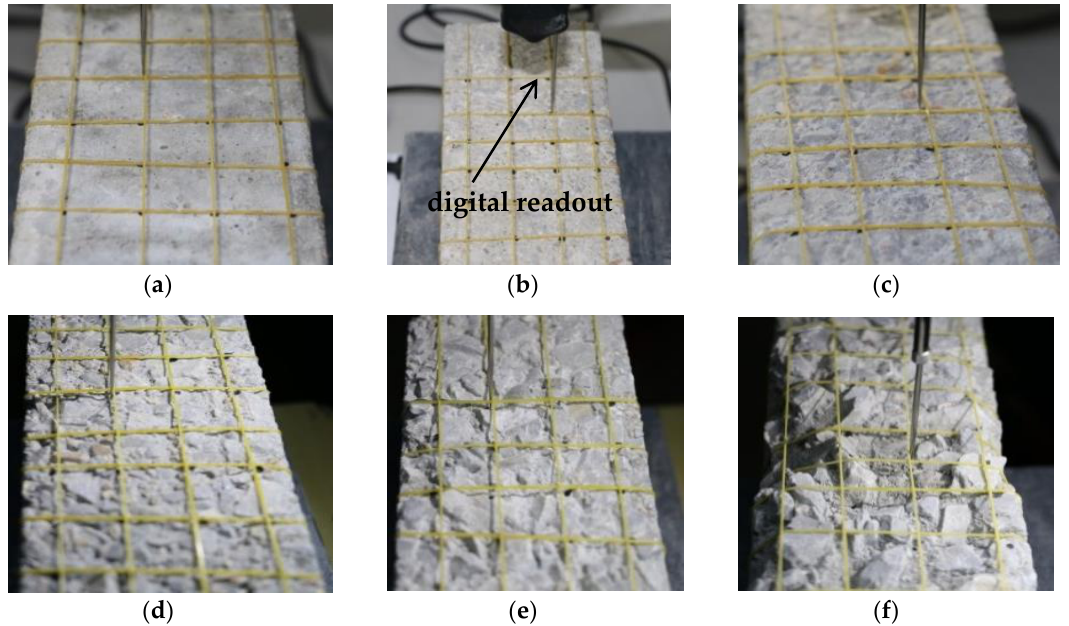
Figure 4. Bump depth values for acquisition points for the digital readout micrometer. ( a ) f0; ( b ) f1;